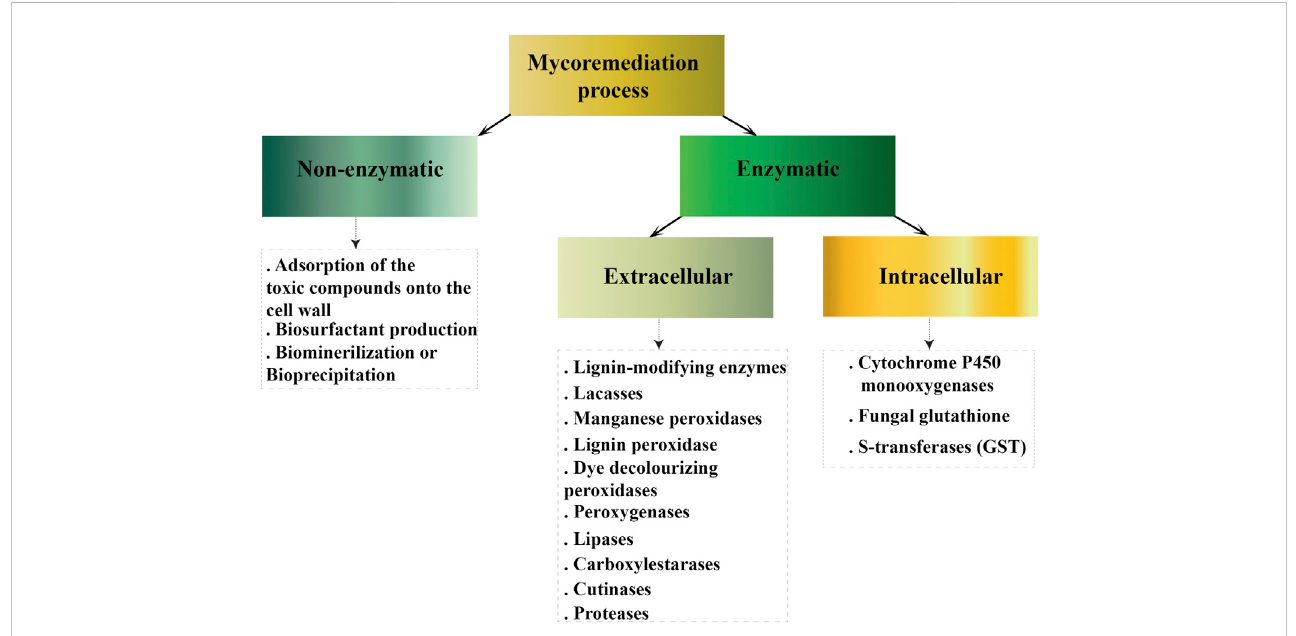
Cellular mechanisms involve in